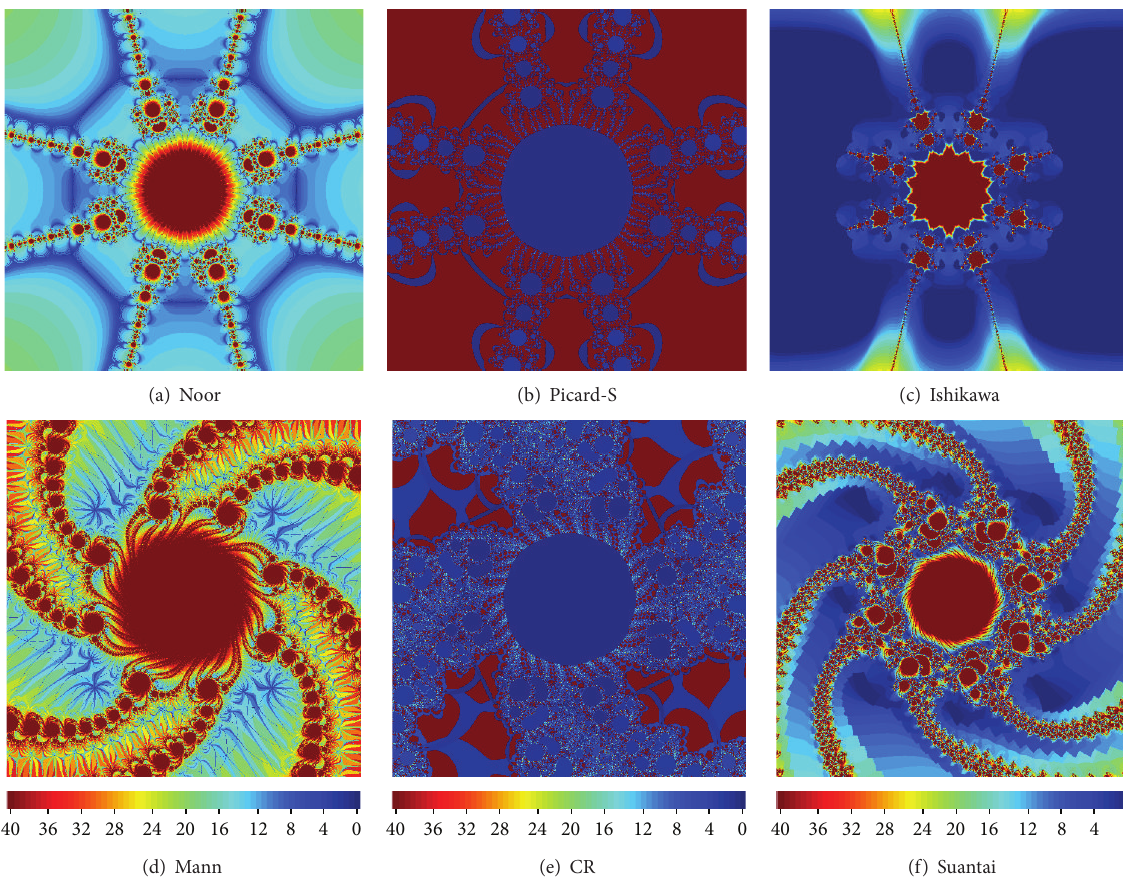
Figure 7: Examples of different convergence tests application for 𝑝 2 , the iterations with: real-valued parameters (a, b, and c) and complex- valued parameters (d, e, and